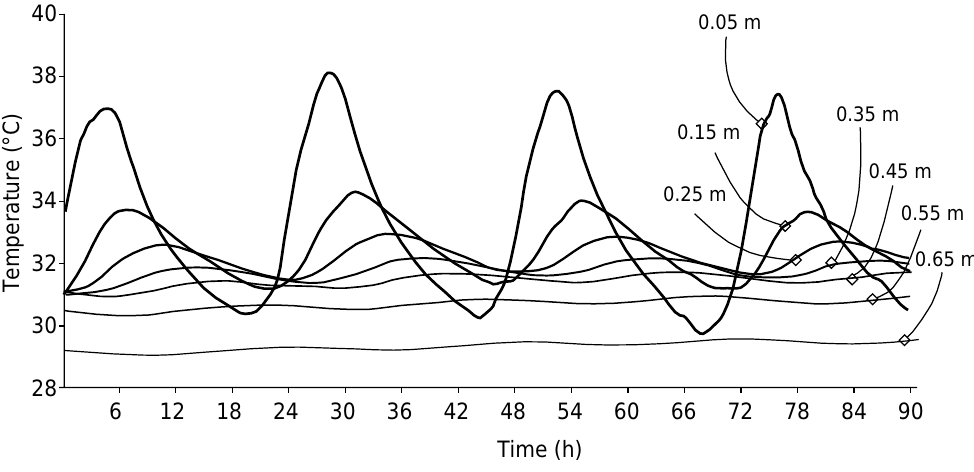
Figure 3. Temperature variation in soil at different depths regarding time. This experiment was conducted from August 7-11, 2013 at Universidad Veracruzana Campus Coatzacoalcos, Veracruz,